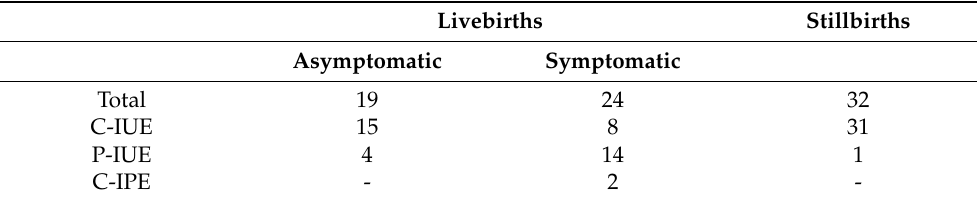
Table 1. Reported cases with confirmed or possible vertical transmission, stratified by the neonatal